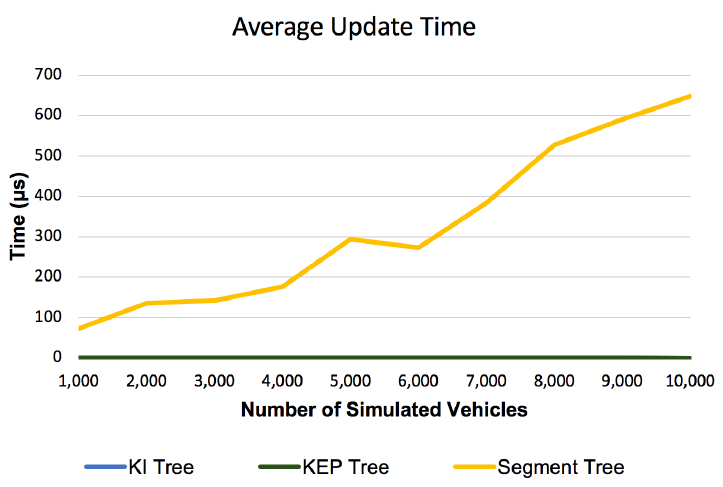
Figure 16. Average Update Time for Segment, KI and KEP